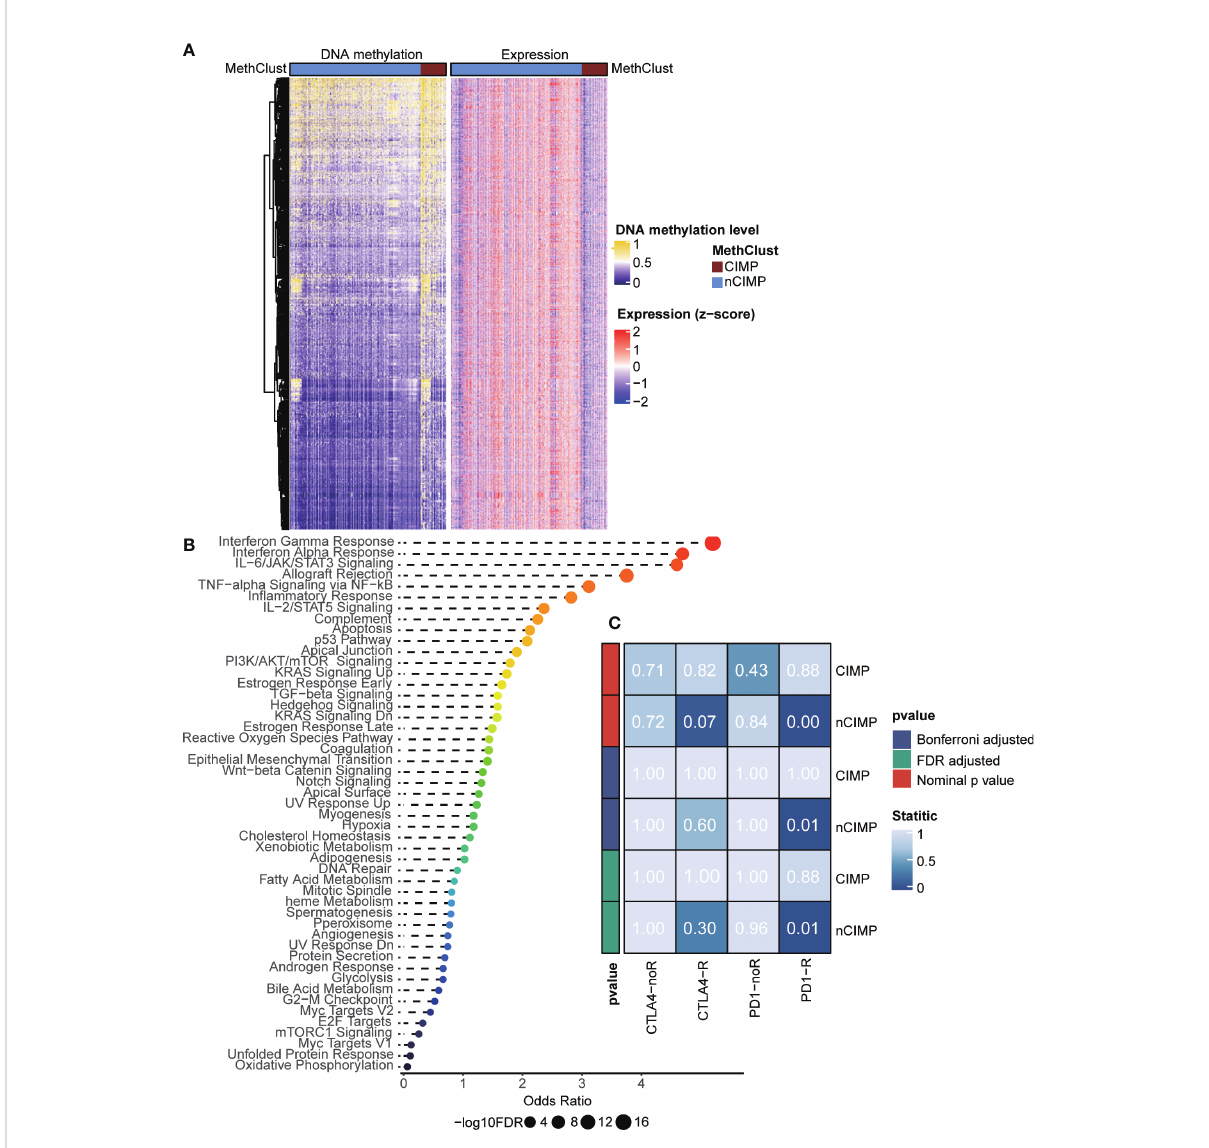
FIGURE 3 Integrated analysis of DNA methylation and transcriptome gene expression, and prediction of sensitivity of methylation phenotypes to immune checkpoint therapy. (A) Heatmap showing the association between DNA methylation and gene expression, presenting with an epigenetic silencing pattern. (B) Dotplot showing the Enrichr functional enrichment of 1,467 adjacent genes. (C) Heatmap of subclass analysis result showing the differences of sensitivity to several immune checkpoint inhibitors between the CIMP and nCIMP